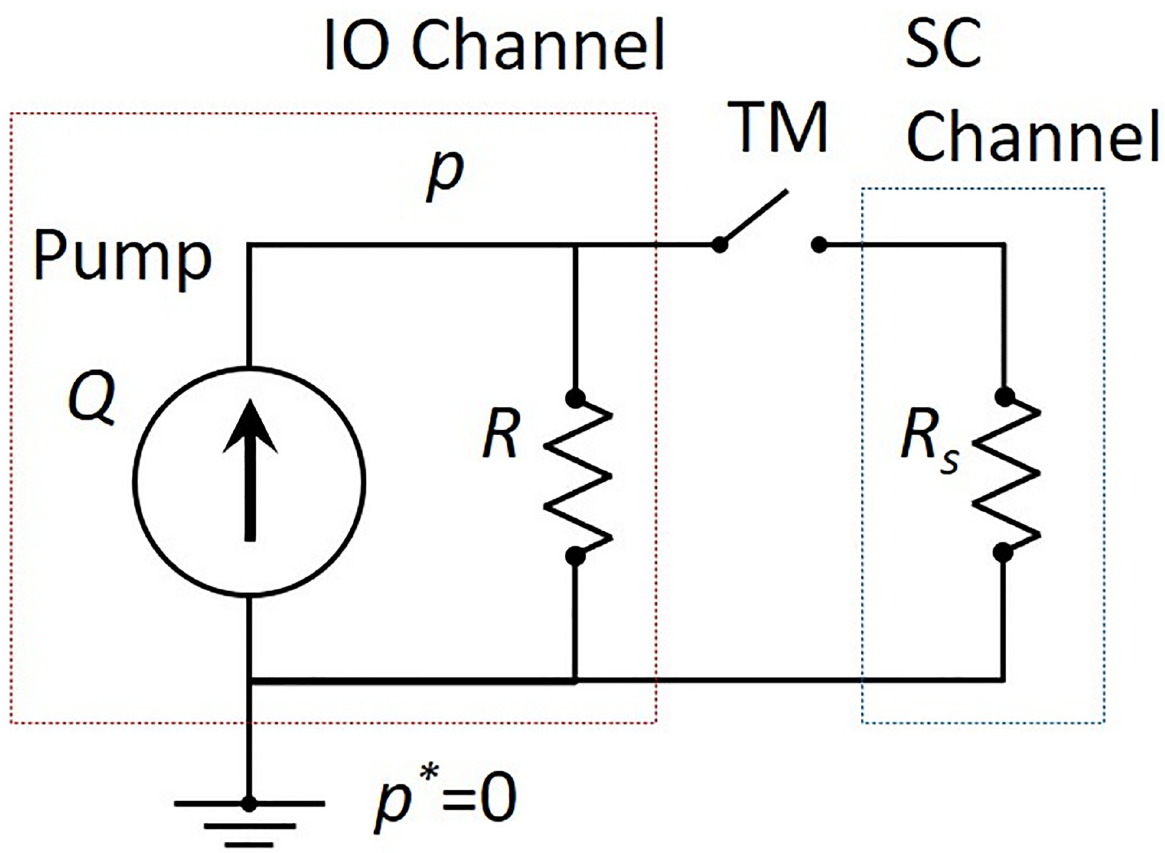
Fig 3. Hydraulic equivalent circuit.